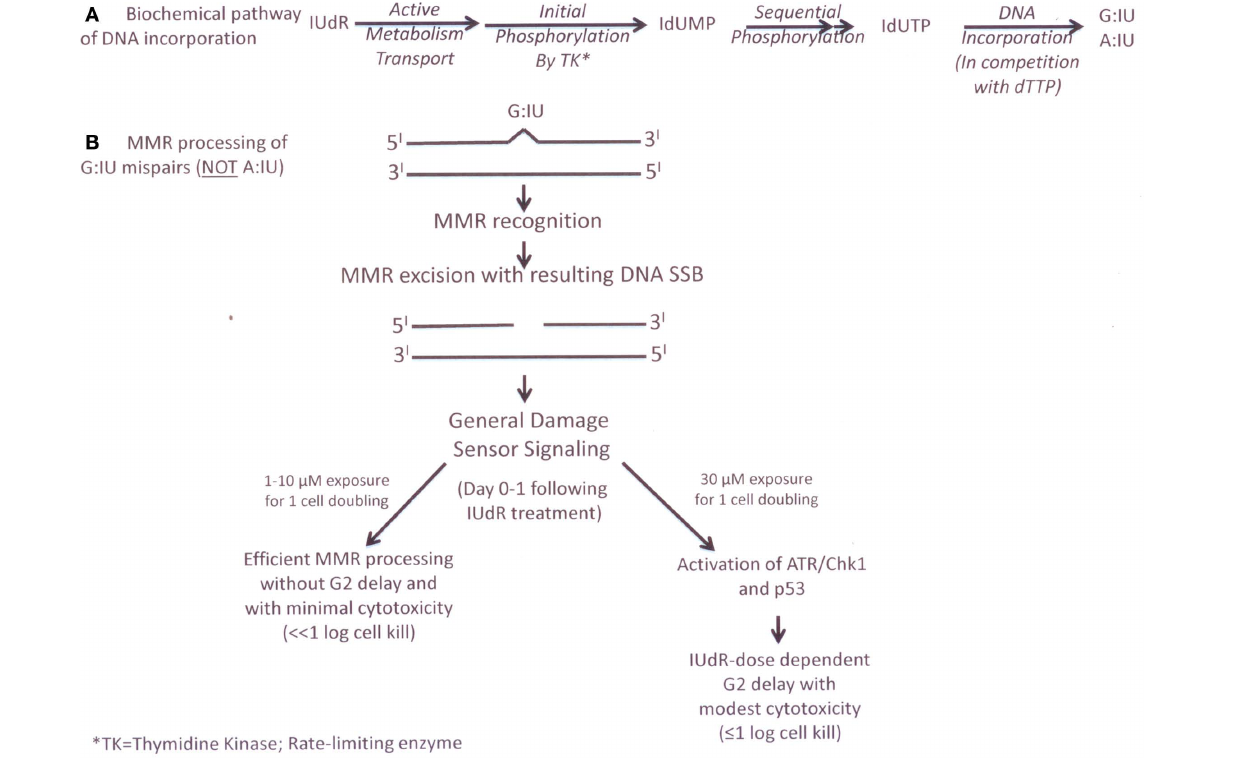
Figure 2 | (A) cellular metabolism of IUdR (B) current experimental biology general damage sensor model of MMK processing of